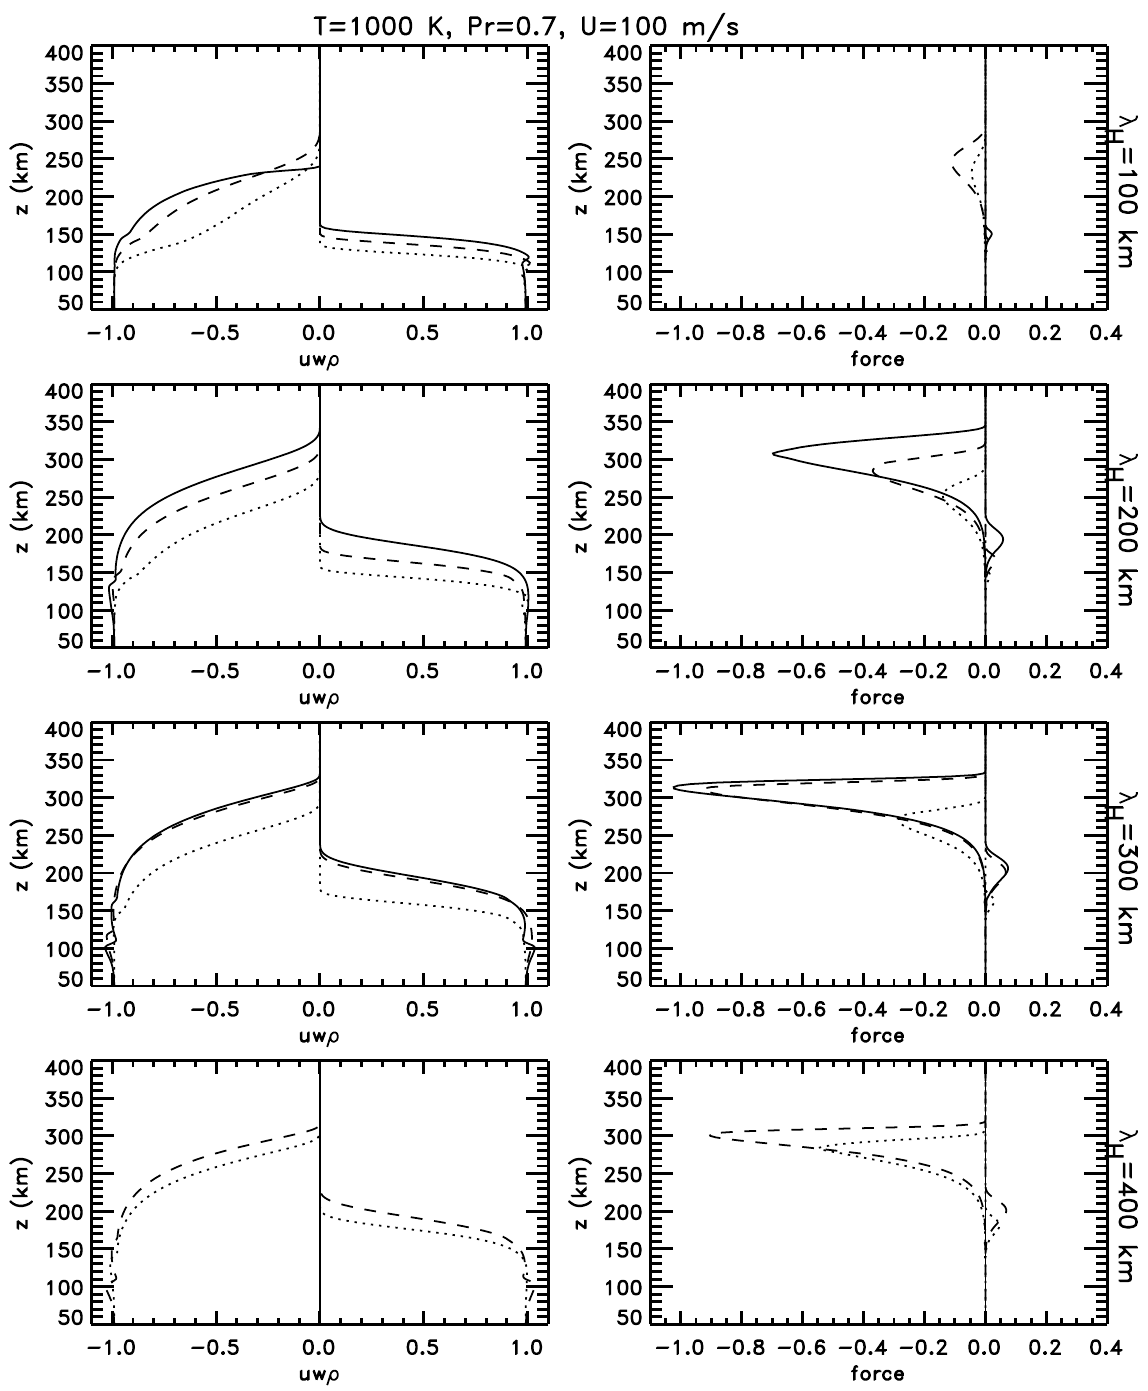
Fig. 10. Surviving momentum flux fractions (left panels) and normalized body forces (right panels) for up-shifted and down-shifted GWs (left and right sides of each panel), λ h =100, 200, 300, and 400km (top to bottom), mean solar forcing (a thermospheric temperature of ∼ 1000K), and a thermospheric zonal wind of 100ms − 1 . Ground-based periods are 15 (solid), 20 (dashed), and 30min (dotted) in each case, except that λ h =400km is precluded by the 1/4 H 2 term in the bottom panels. Note that it is the up-shifted GWs of higher ground-based (and intrinsic) frequencies and intermediate λ h that penetrate to the highest altitudes and have the largest implied body forces. The exception is the 15-min period GW with λ h =100km, which is reflected at a turning level at an altitude of ∼